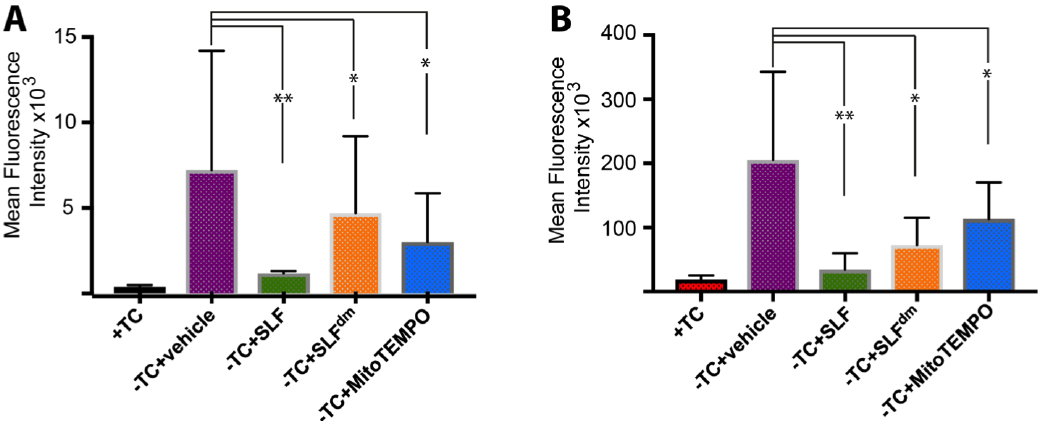
Figure 9. Quantification of the mean fluorescence intensity signal in confocal images of MC65 cells stained with the anti-AβO antibody A11 (panel A , see Figure 8) or the generic anti-Aβ antibody 4G8 (for total Aβ, panel B , see Figure 10). The effect of SLF, SLF dm , and MitoTEMPO co-addition on the intracellular accumulation of Aβ in APP-induced MC65 cells is given by the green, orange, and blue bars, respectively, and is compared to the −TC vehicle control. Statistical analysis of fluorescence intensity by one-way ANOVA gives * p < 0.01, ** p < 0.001, n = 3. Error bars represent the standard error, which is described in the Methods section.